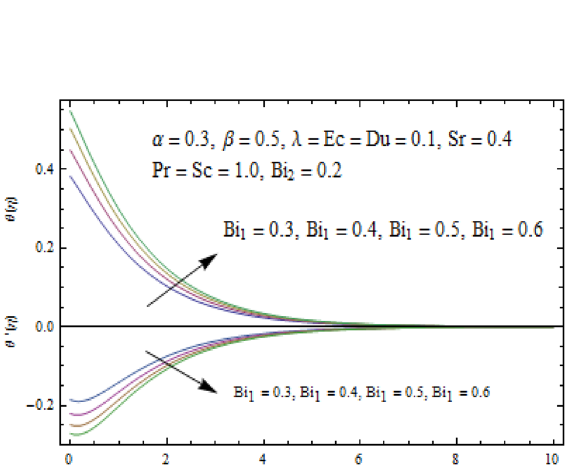
Fig. 14 Impact of R on θ(η)